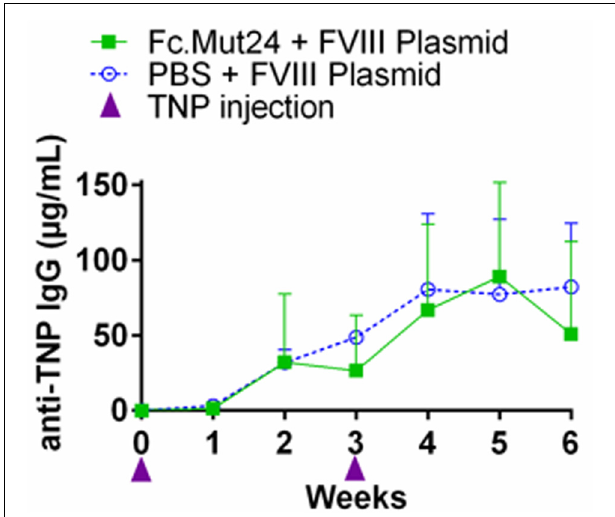
FIGURE 6 | Evaluation of the immune competence of the Fc.Mut24-treated and the FVIII plasmid gene therapy-treated mice. Trinitrophenyl (TNP) antigen challenge was performed to evaluate if the mice treated with Fc.Mut24 and FVIII plasmid gene therapy remain immune-competent to other unrelated antigens. At 16 and 19 weeks after the initial Fc.Mut24 treatment, the experimental ( n = 3) and the control naïve hemophilia A mice ( n = 3) were injected with TNP-keyhole limpet hemocyanin and TNP-Ficoll emulsified in CFA to induce a non-specific immune response. The anti-TNP IgG concentrations were measured via ELISA ( p = 0.66). The p -values were calculated at multiple time points between groups using repeated-measures